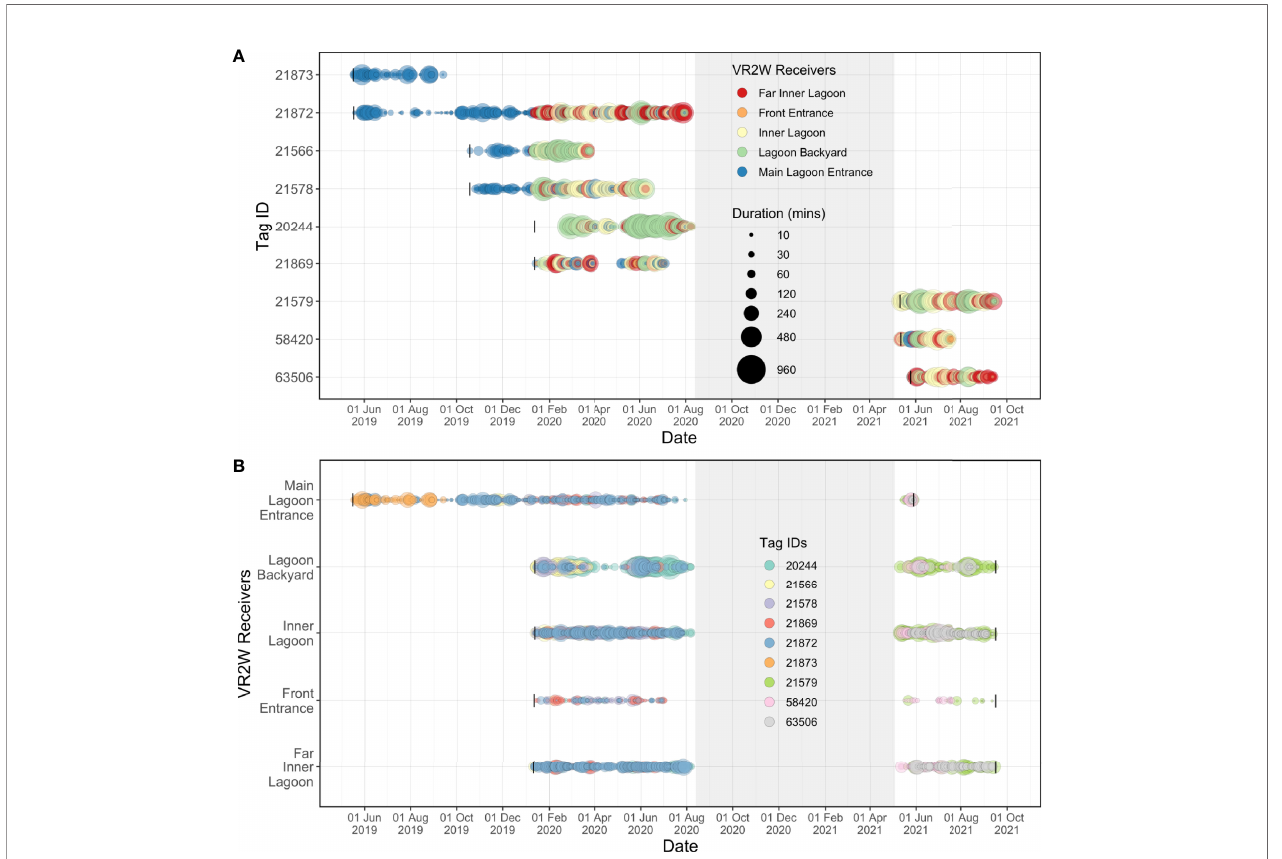
FIGURE 6 | Acoustic detections recorded over time for each tagged juvenile M. alfredi at each receiver deployed in the Wayag lagoon between May 2019 – September 2021. The size of the bubbles indicates (A) the duration of visitations recorded by each receiver for each individual; and (B) the duration of visitations recorded for each individual at each receiver site. The grey shaded areas denote the period during which there were no active acoustic transmitters on manta rays in the lagoon, yet the receivers were still deployed in the lagoon. Black vertical lines in Panel A represent deployment dates of each transmitter, while black vertical lines in Panel B represent deployment and recovery dates of each